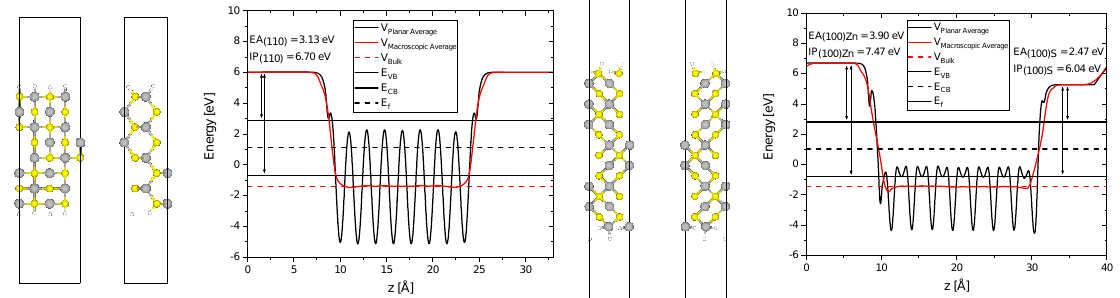
Figure A2. View along different axes along the unit cell of for the (110) ( left ) and (100) ( right ) surface slab calculation and the corresponding calculated planar and macroscopic average electrostatic